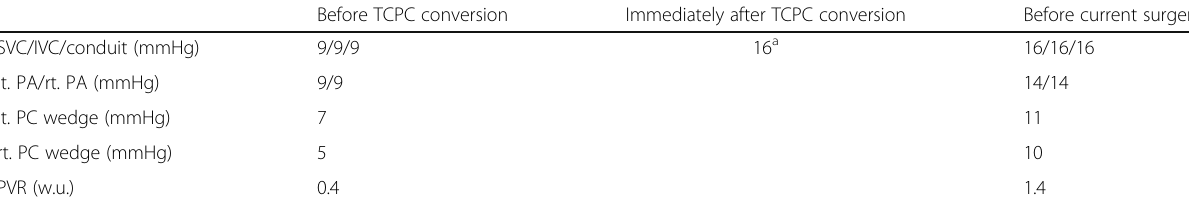
Table 1 Preoperative cardiac catheter laboratory findings Before TCPC conversion Immediately after TCPC conversion Before current surgery